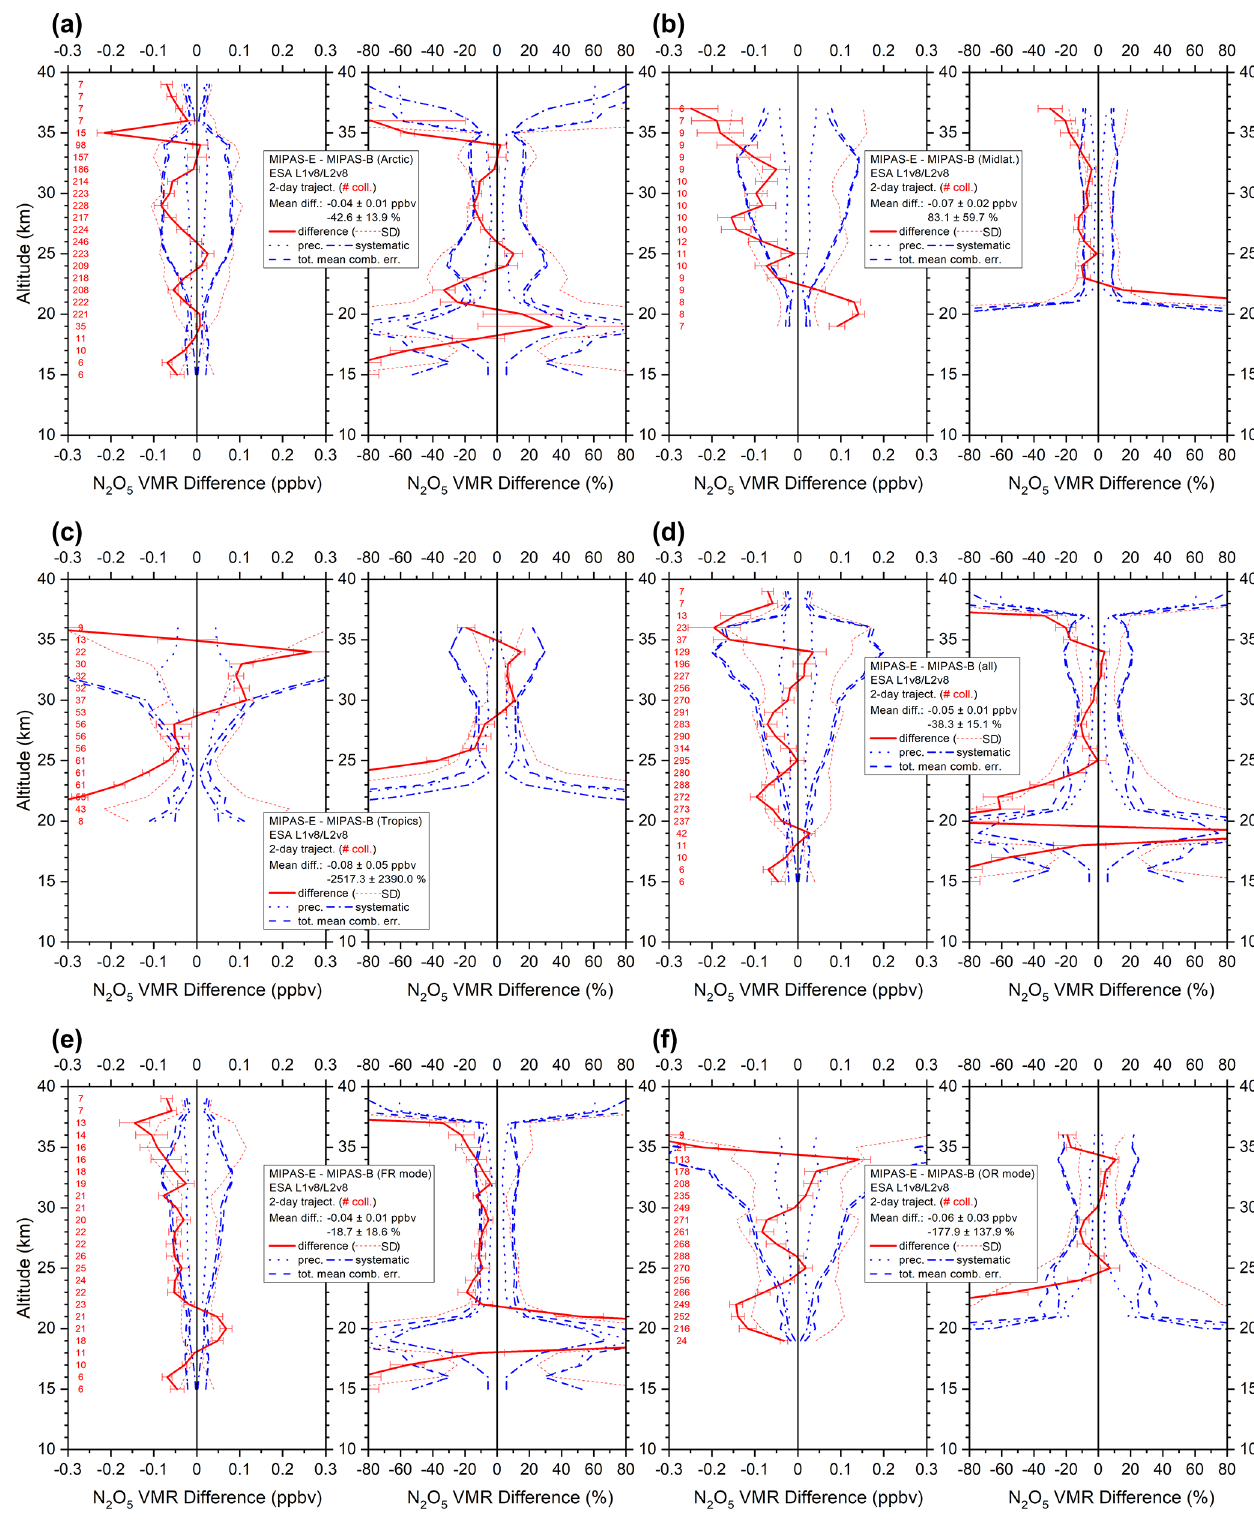
Figure 9. Same as Fig. 3 but for N 2 O 5